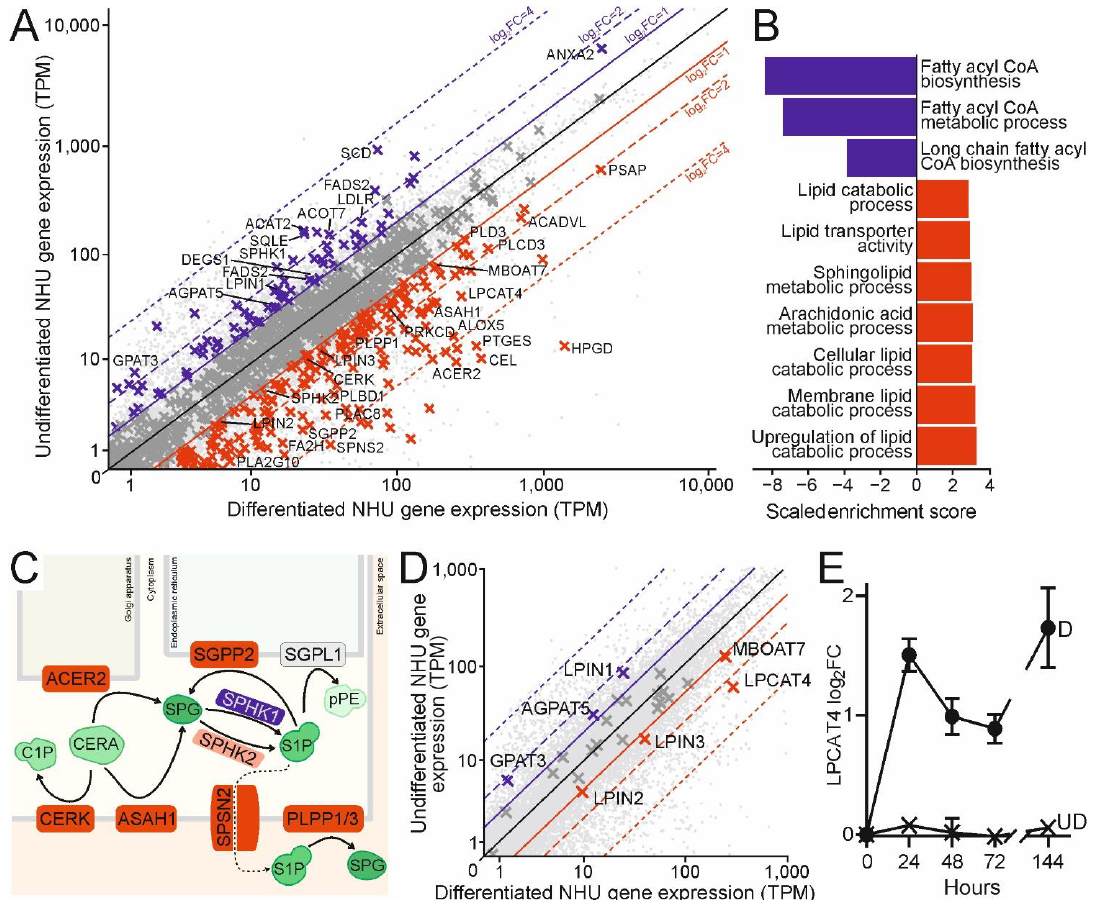
Figure 2. Modulation of human urothelial lipid biosynthesis induced upon differentiation. ( A ) Gene expression plot comparison of three donor-matched cultures before [UD] and after [D] induction of the NHU differentiation protocol. Genes with gene ontology terms linked to lipid processing are shown as crosses, otherwise dots. Red crosses exhibit greater than doubling of expression in the differentiated cultures, and vice versa for the blue crosses, when corrected p values were less than 0.05. Genes of particular interest are indicated. ( B ) Lipid pathways enriched in differentiated (red) or undifferentiated (blue) states. Scaled enrichment score is equal to the GSEA normalised enrichment score multiplied by the reciprocal of the FDR. ( C ) Urothelial “sphingolipid rheostat” showing the up- regulation of gene transcript upon differentiation where protein products deplete ceramide (CERA) or sphingosine-1-phosphate (S1P), likely increasing sphingosine (SPG) levels. Upregulated genes in red, downregulated in blue, partial upregulation in pink, no significant change in grey. Changing genes are named in ( A ). Metabolites in green. C1P: ceramide-1-phosphate; pPE: phosphoethanolamine. ACER2 hydrolysis of ceramides commonly produces sphingosine and stearic acid (18:0); the latter may explain the slight increase in 18:0 PC fatty acyl chains seen upon differentiation (Figure 1D). ( D ) Same as the expression plot in ( A) but highlighting genes from the Kennedy Pathway or Land’s Cycle only, naming those with statistically significant changes, highlighting the 5.37-fold upregulation of LPCAT4 upon differentiation (Benjamini-Hochberg corrected p = 4.76 × 10 − 6 ). ( E ) RT-qPCR time- course of LPCAT4 expression upon differentiation [D] with values normalised to the undifferentiated [UD] 0 h levels. Error bars represent standard deviation from three technical replicates of a single NHU donor